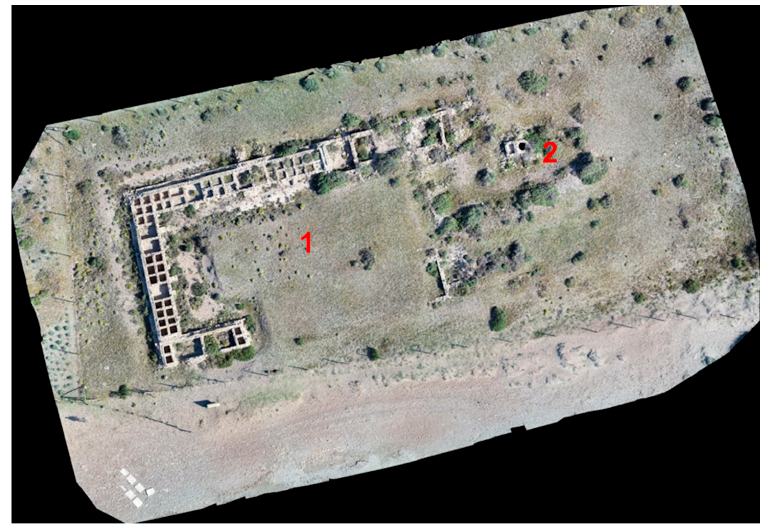
Figure 3. Orthophotography zenithally view of the site. 1: central courtyard of the building; 2: location of the hydraulic supply structures.